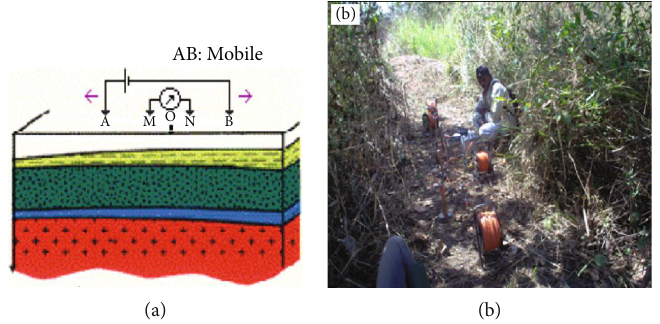
Figure 3: (a, b) Schlumberger electrical sounding method.